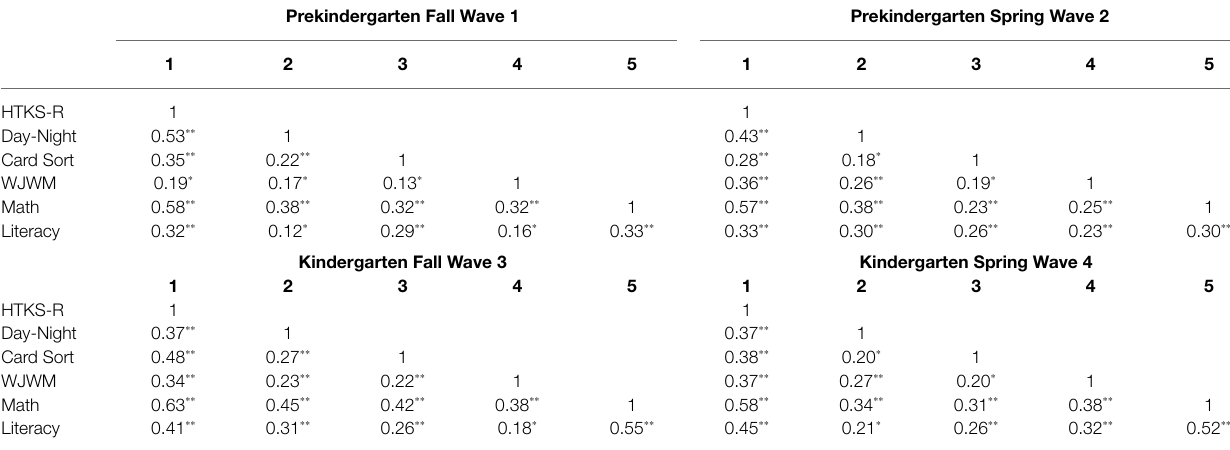
TABLE 2 | Within-timepoint Pairwise Correlations for EF and Academic